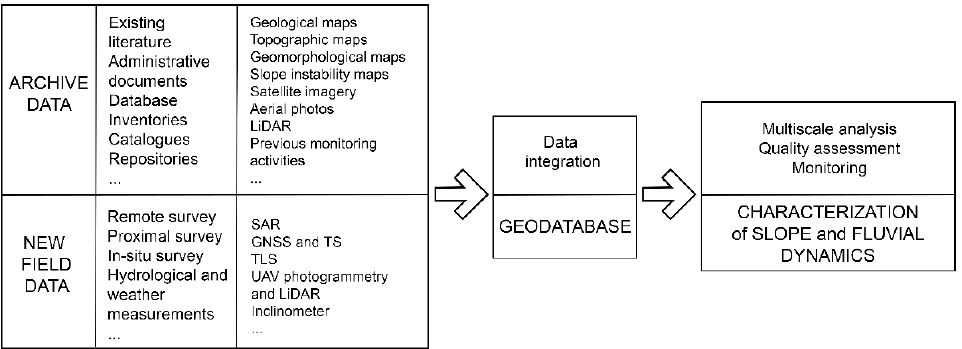
Figure 1. Workflow of the multidisciplinary approach combining and integrating different remote and proximal sensing techniques and archive data applied to a study area.